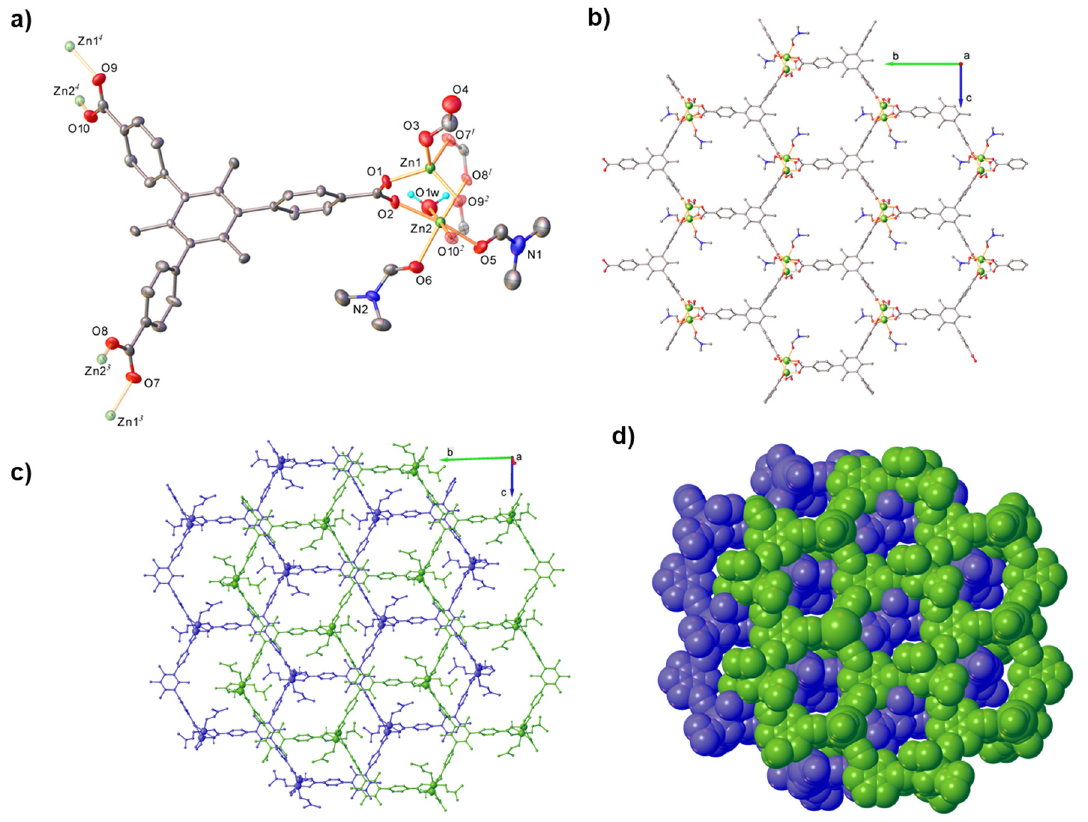
Figure 1. Crystal structure of compound 1 . ( a ) View of the asymmetric unit with thermal ellipsoids at 50% level and selected atom labeling showing the coordination of the Zn atoms. Symmetry-generated atoms are shown with faded colors; ( b ) View of the 2D coordination polymer; ( c ) Crystal packing viewed along the a -axis; ( d ) Space-filling model. Non-relevant H-atoms are not shown. Symmetry codes: 1 ) 1 – x , ½ + y , ½ – z ; 2 ) x – 1, y, z – 1 ; 3 ) 1 + x, y, 1 + z; 4 ) 1 –x, ½ + y, ½ + z.